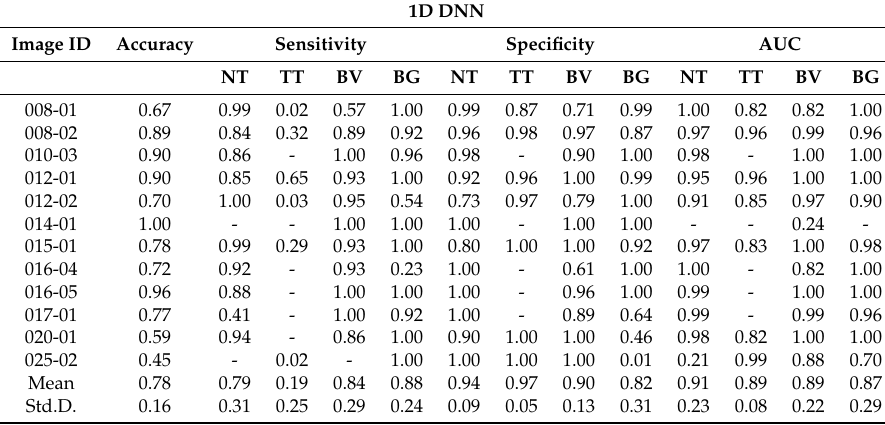
Table A5. Overall results for the 1D DNN. Accuracy, sensitivity, specificity, and AUC are calculated for each class. NT: Normal tissue, TT: Tumor tissue, BV: blood vessels, BG: Background. 1D DNN Image ID Accuracy